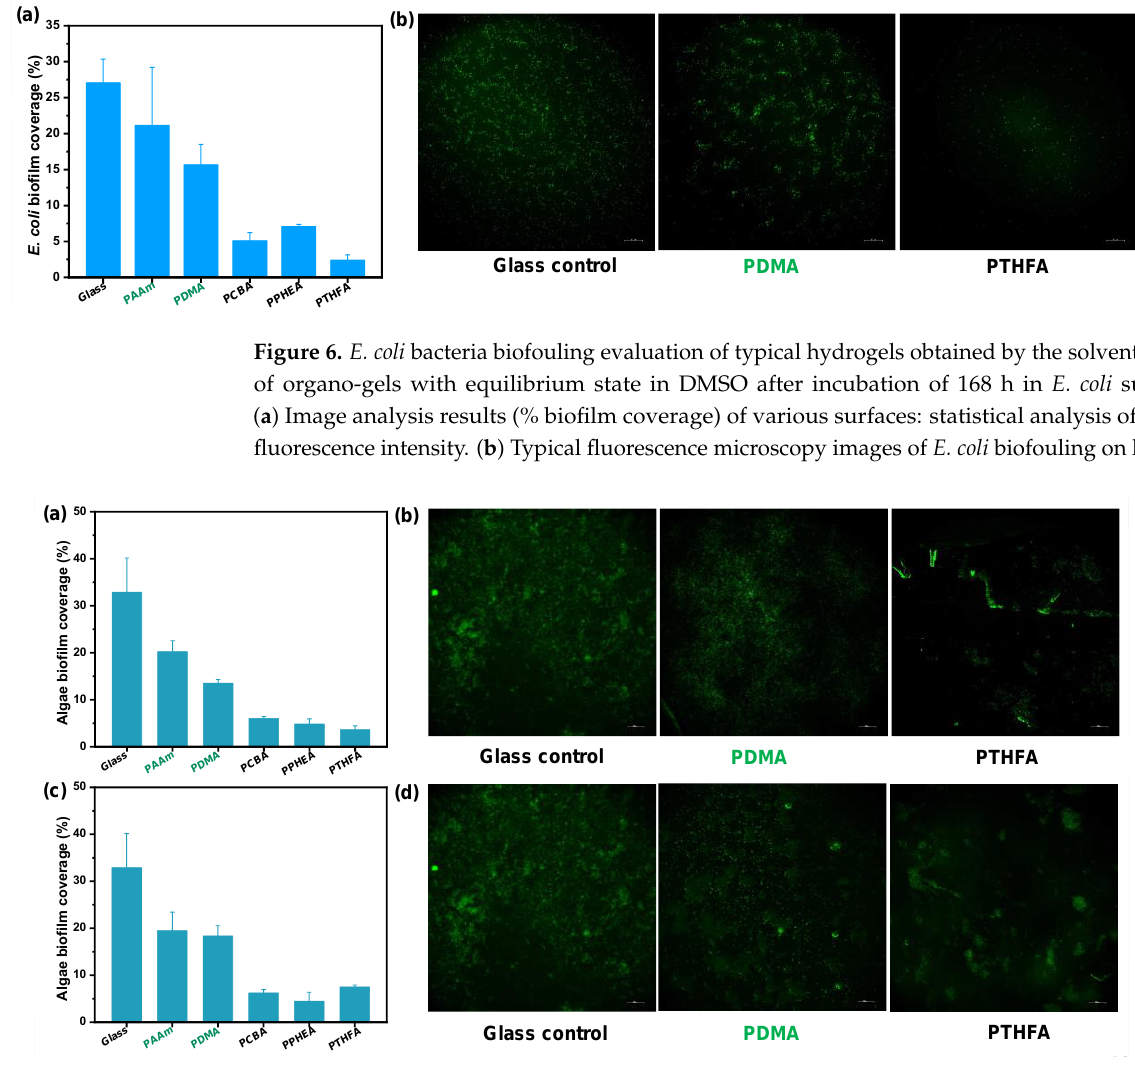
Figure 7. Algae biofouling evaluation of typical hydrogels obtained by ( a , b ) the direct solvent exchange of as-prepared organo-gels after polymerization, and ( c , d ) the solvent exchange of organo-gels with equilibrium state in DMSO after incubation of 168 h in S. platensis suspension. ( a , c ): Image analysis results (% biofilm coverage) of various surfaces: statistical analysis of the mean fluorescence intensity. ( b , d ): Typical fluorescence microscopy images of algae biofouling on glass substrate and hydrogels. Note that the glass control in Figures b and d are